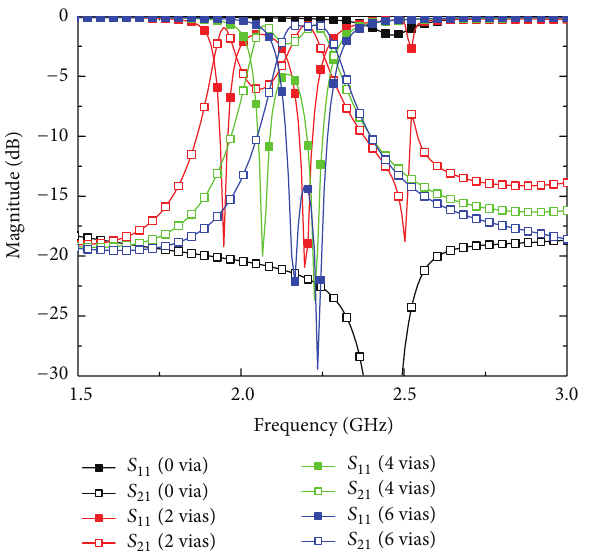
Figure 3: Simulated frequency response relative to changes in the height ℎ 1